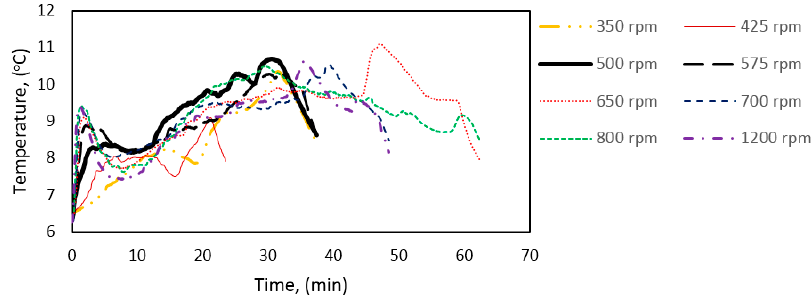
Figure 16. Temperature buildup in a 141.4 mL cell due to exothermic heat release during gas hydrate growth (50 mL water content, 6 °C in cooling bath).